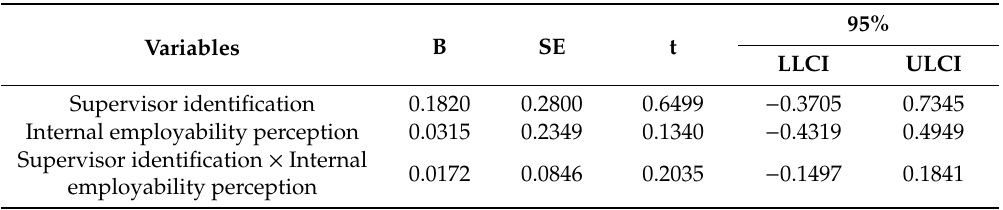
Table 5. Results of the moderating e ff ect of external employability perception in the relationship between supervisor identification and